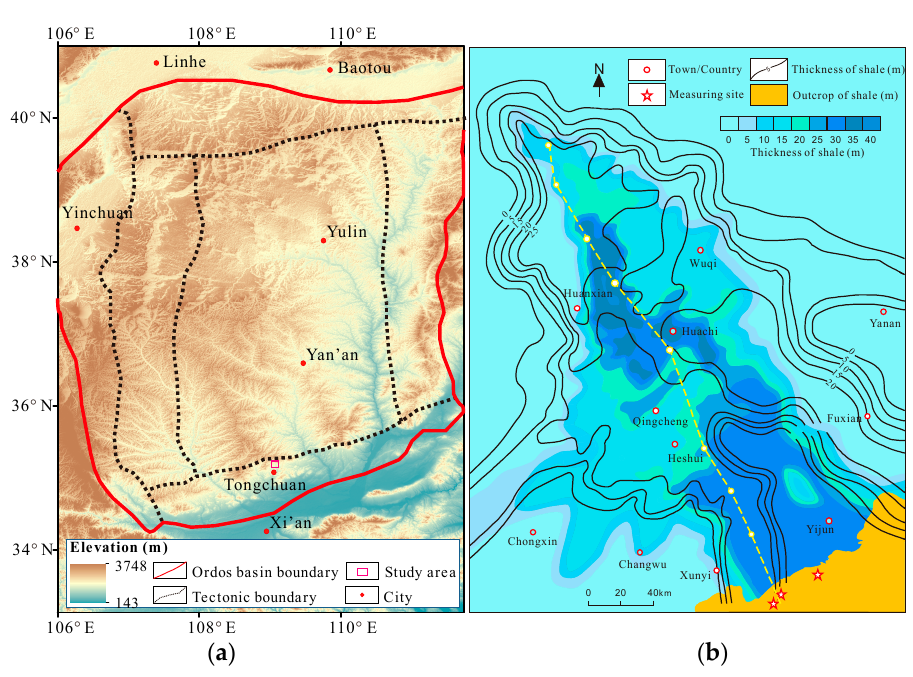
Figure 1. ( a ) Tectonic map of the Ordos Basin; ( b ) distribution of shale rocks of the Yanchang Formation [49].